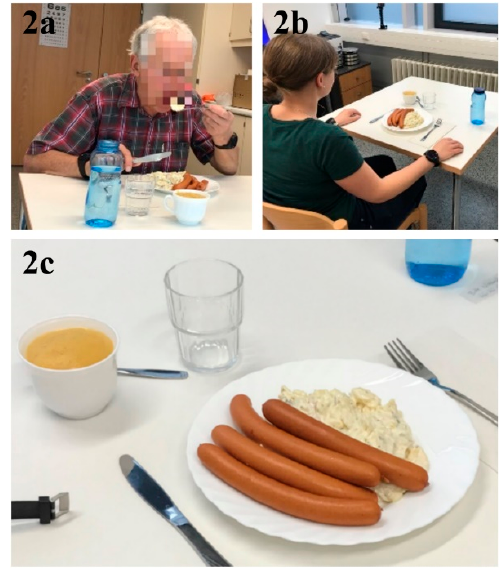
Figure 2. ( a , b ) The clinical lunch setting, and ( c ) the food that was served during the lunch meal (200 g sausages, 400 g potato salad, and 200 g apple purée).